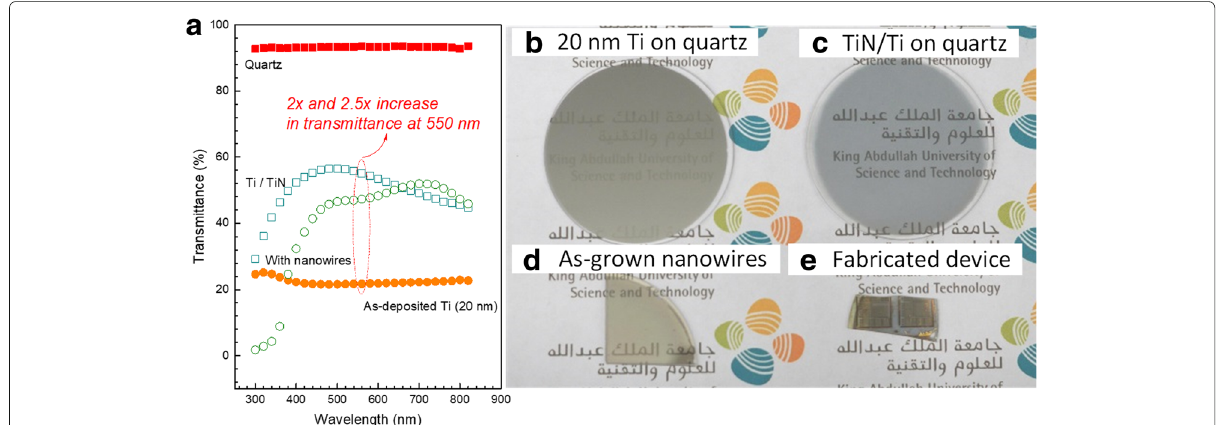
Fig. 3 a Transmittance measurement results for bare quartz, quartz substrate coated with 20 nm of Ti, quartz substrate coated with TiN/Ti layer, and as-grown nanowire sample on quartz. b Optical photograph of quartz coated with 20 nm Ti; c quartz coated with Ti which has undergone partial nitridation; d as-grown nanowire sample; and e fabricated LED device on quartz